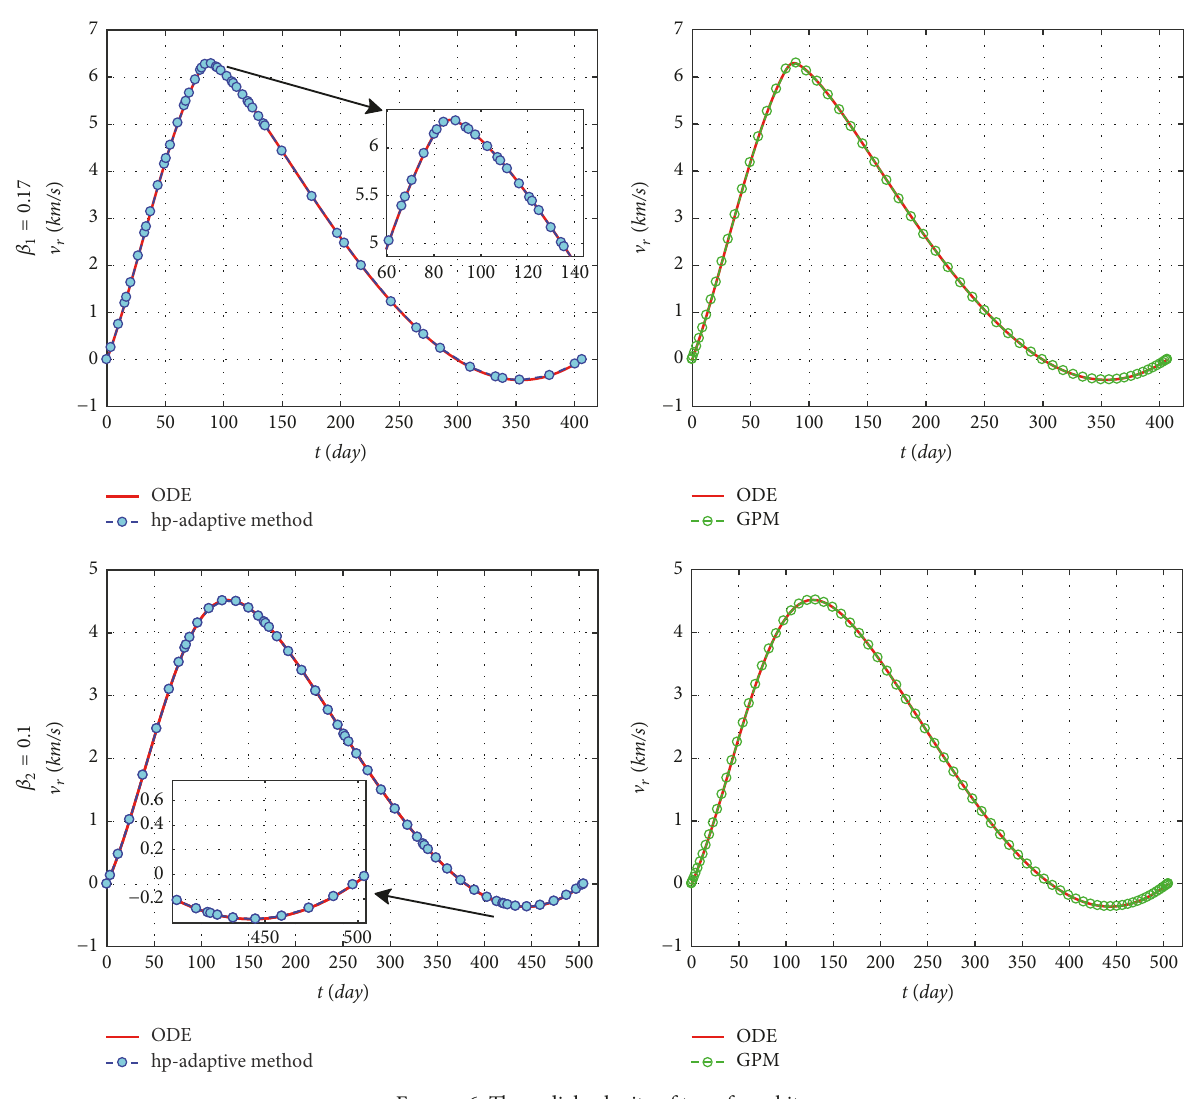
Figure 6: The radial velocity of transfer orbit.